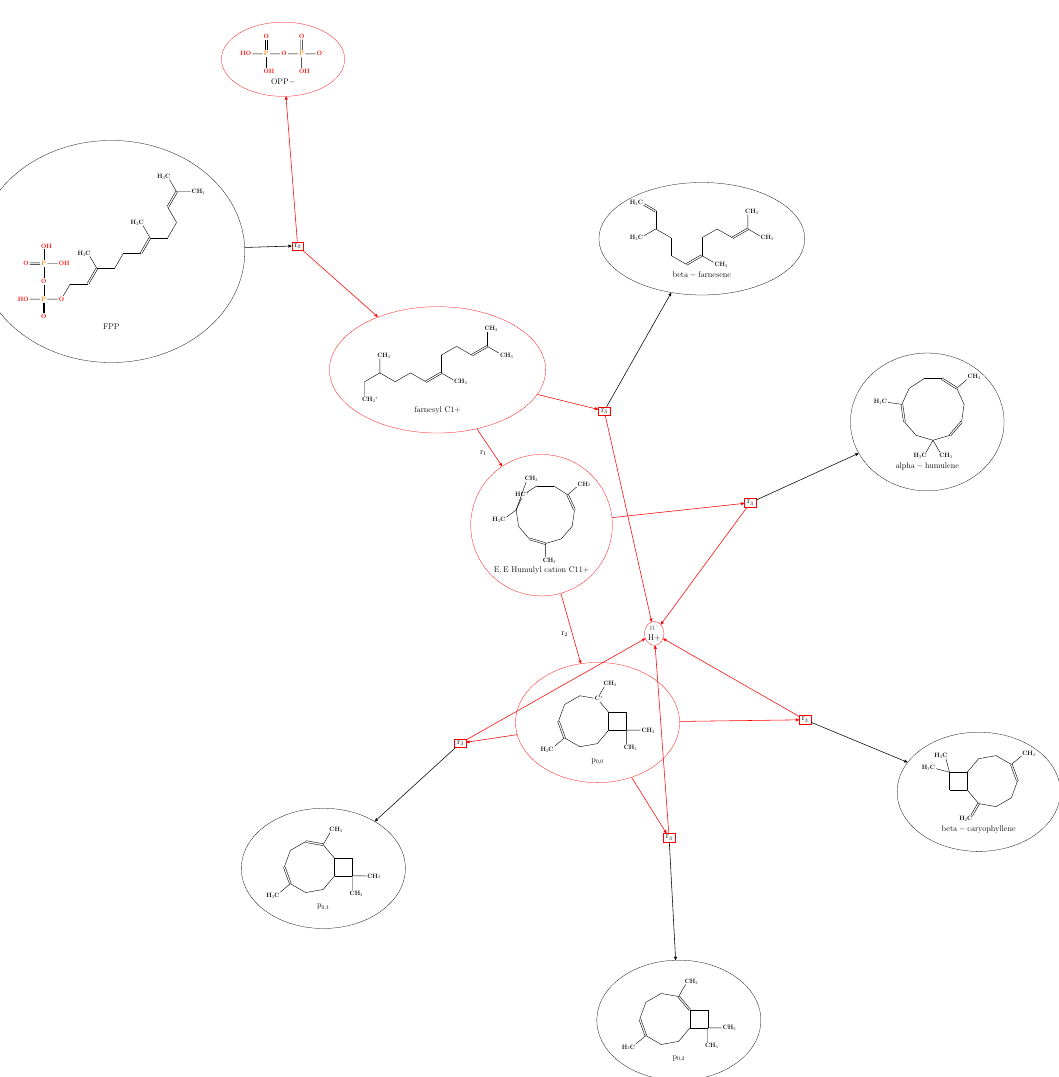
Figure 2. The plotted result of Simulation 02 for β -caryophyllene, α -humulene, β -farnesene, and the side-predicted compounds from